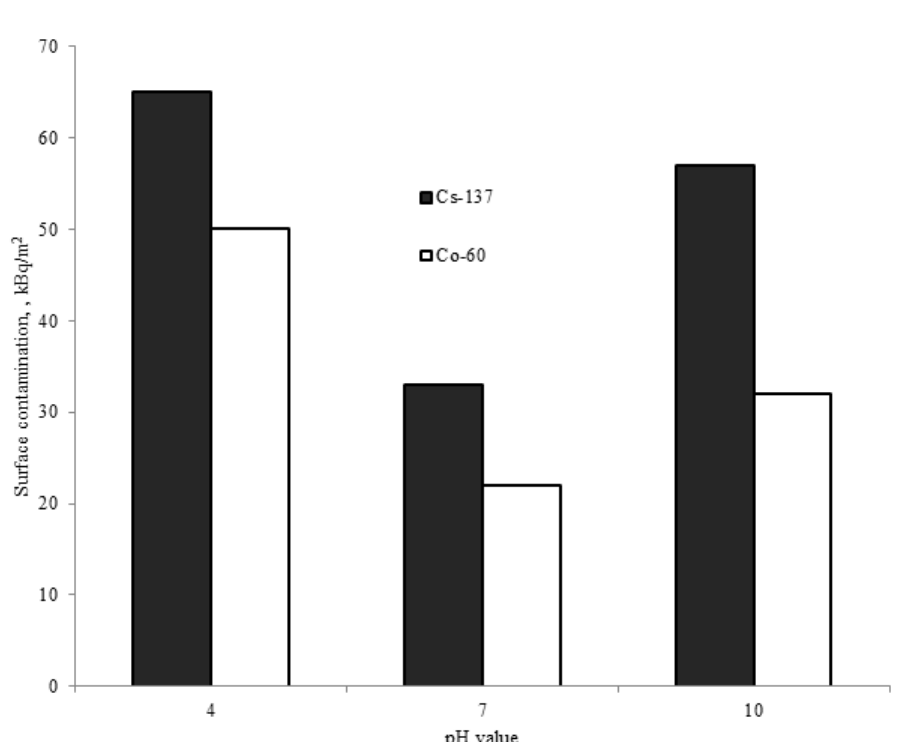
Figure 7. Radioactive contamination on the surface of the alloy specimens after autoclave experi- ments.